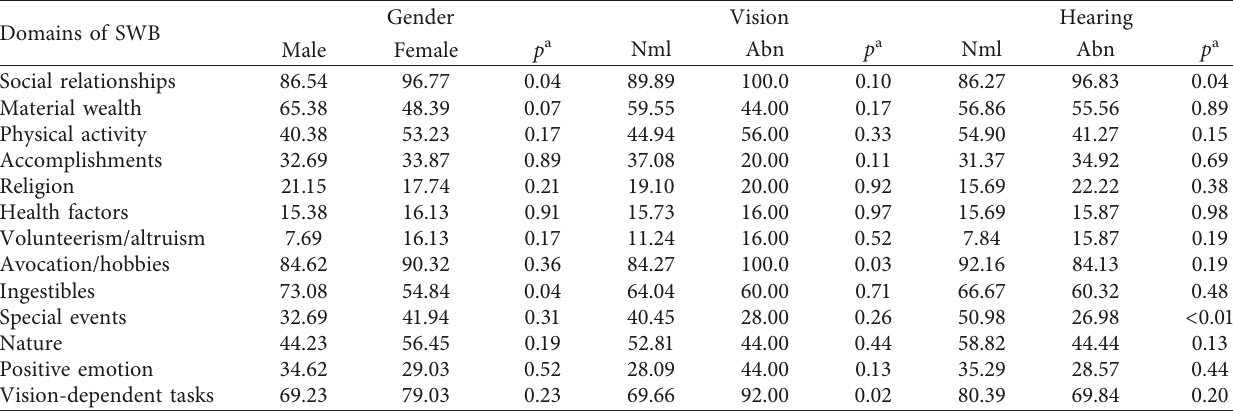
Table 4: Name things that make people happy: comparison of response patterns by gender, vision, and hearing status. Gender Domains of SWB